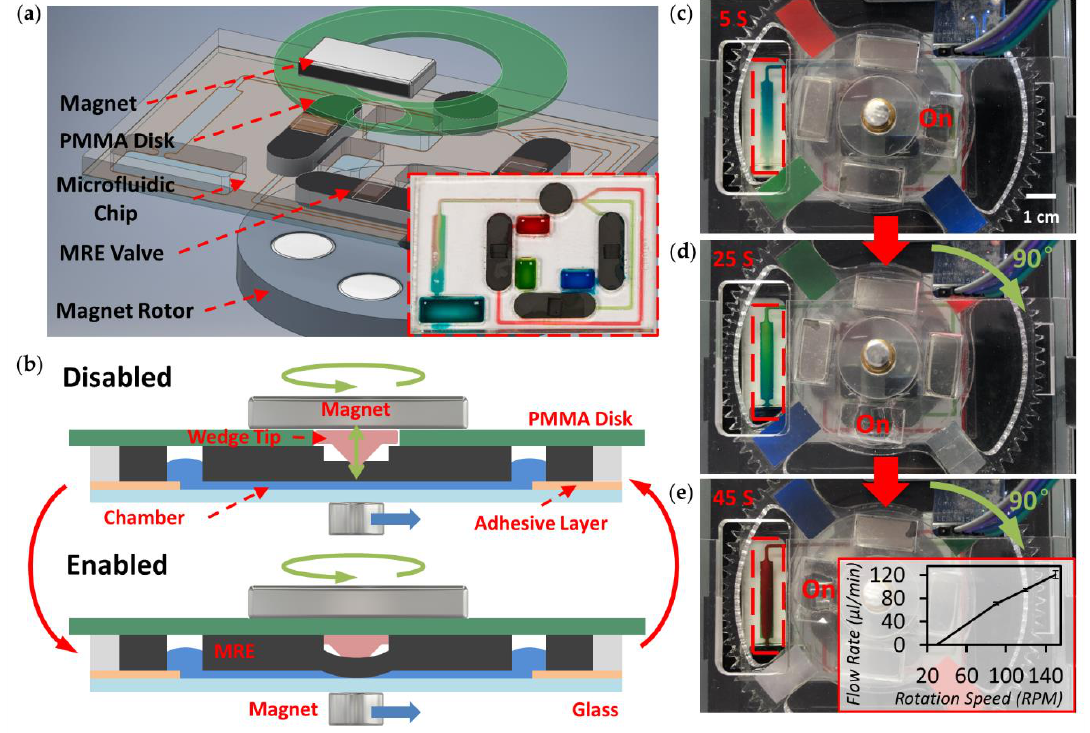
Figure 4. Schematic of setup for integrated MRE valve. ( a ) Exploded schematic representation of the valve setup. The lower inset shows the actual image of the chip design for sequential pumping. ( b ) The disabled and enabled working states of the MRE valve. ( c – e ) Sequential snapchats showing achievement of sequential pumping. The lower insert plot shows the flow rate vs. rotation speed of the magnet rotor.